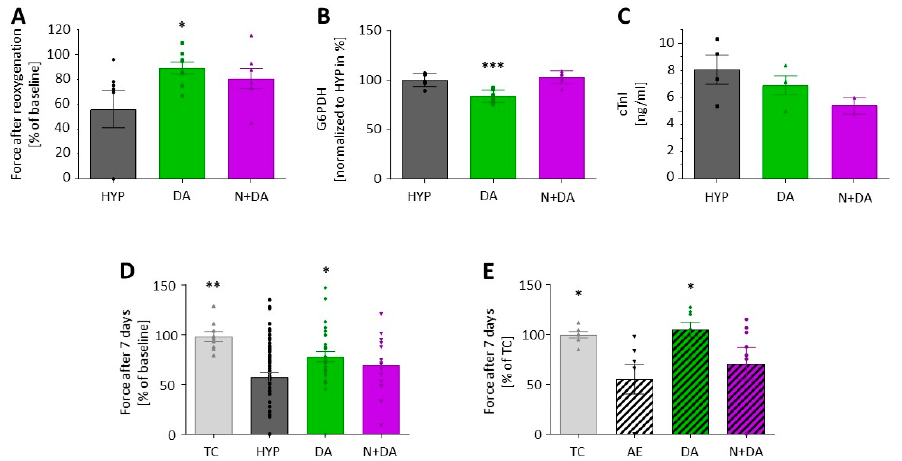
Figure 4. ( A – D ) Effect of preconditioning with [ D -Ala 2 , D -Leu 5 ]-Enkephalin (DADLE) 100 nM, 3 × 10 min, (DA) or DADLE 100 nM plus naloxone 10 µM (N+DA) compared to the hypoxic group